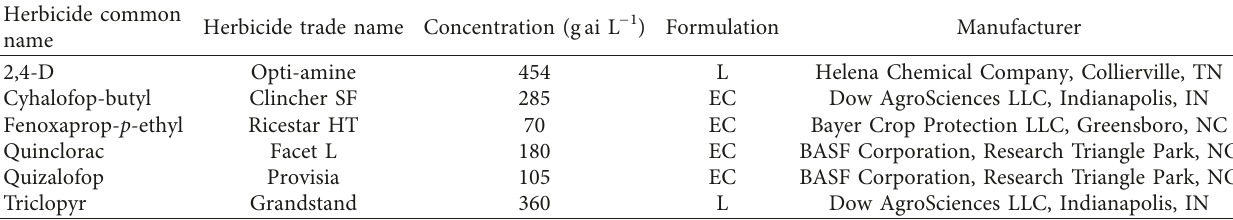
Table 1: Source of